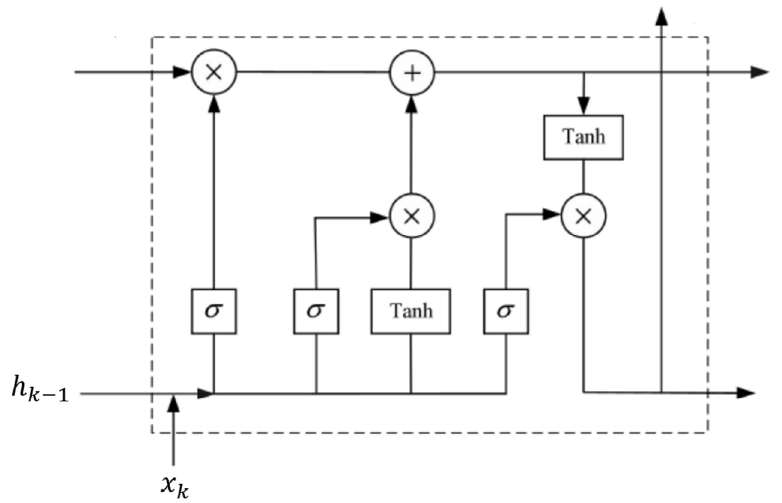
Figure 2. The cell structure of the LSTM.